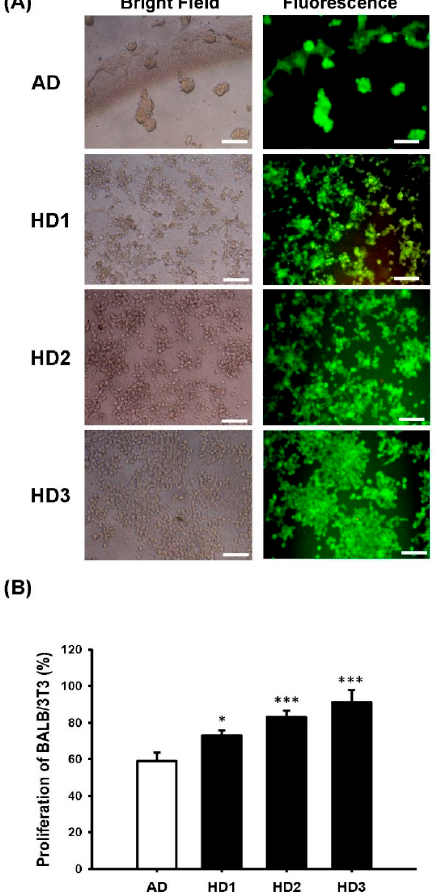
Figure 3. Comparison of cell viability on silk fibroin film purified from alkaline degumming (AD) and heat degumming for 1, 2, and 3 h (HD1, HD2, and HD3). ( A ) Merged images of cells grown on different SF-films for 24 h. Cells were treated with bright light and LIVE/DEAD stain under a fluorescence microscope. The polyanionic dye calcein is retained in live cells, resulting in an intense uniform green fluorescence (ex/em ~495/~515 nm). DNA intercalating dye EthD-1 enters cells, producing a bright red fluorescence in dead cells (ex/em ~495/~635 nm). Scale bars = 100 µ m. ( B ) Comparison of proliferation of BALB/3T3 fibroblasts grown on the SF-films prepared from different degumming procedures. Fully reduced alamarBlue reagent of the same quantity was used as the positive control (100%). Statistically significant differences between AD and HD were determined by Dunnett’s multiple comparison post hoc test. * p < 0.05 and *** p < 0.001; n = 4; all error bars represent the standard error of the